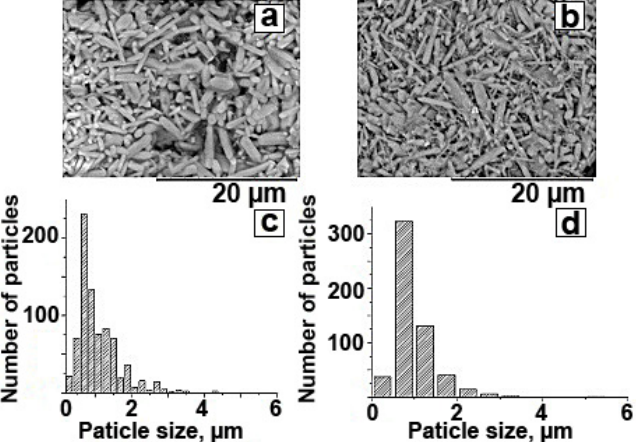
Figure 4. SEM images of composites: ( a ) Zn x HA-PLGA (x = 0.1), ( b ) Zn x HA-PLGA (x = 0.5) and the quantitative distribution of particles over the surface: ( c ) Zn x HA-PLGA (x = 0.1), ( d ) Zn x HA-PLGA (x = 0.5). Table 2. Elemental composition of Zn x HA